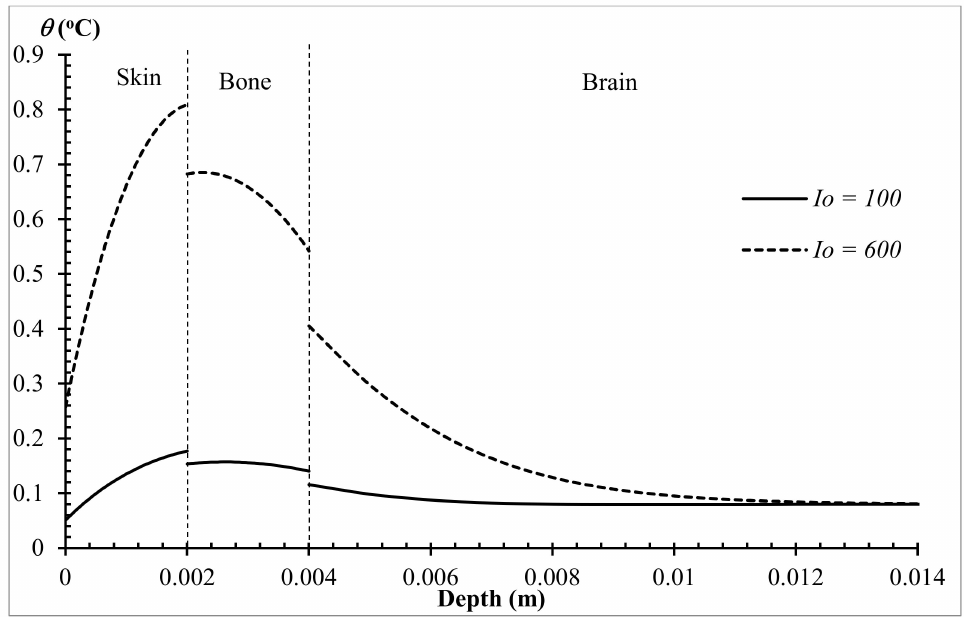
Figure 15. The dynamical temperature increment with various power densities on the child’s